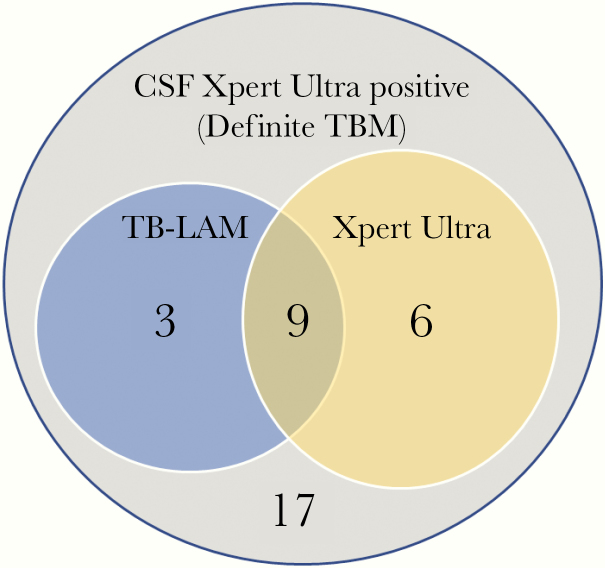
Venn diagram illustrating overlap of tuberculosis-lipoarabinomannan (TB-LAM) and urine Ultra among those with definite TB meningitis (TBM). Of 35 persons with definite TBM tested with both assays, a total of 18 (51%) had positive urine test, 12 (34%) were urine TB-LAM positive, and 15 (43%) were urine Ultra positive with an overlap of 9 of 18 (50%) positive participants being positive by both assays. Overall, 49% (17 of 35) with definite TBM, diagnosed by positive CSF Xpert Ultra, had negative urinary tests.